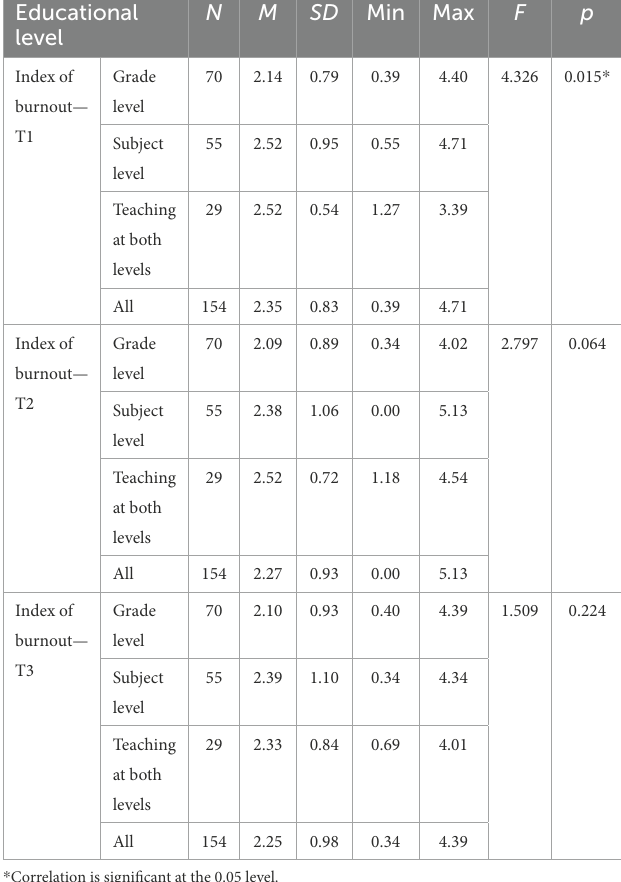
* Correlation is significant at the 0.05 level.